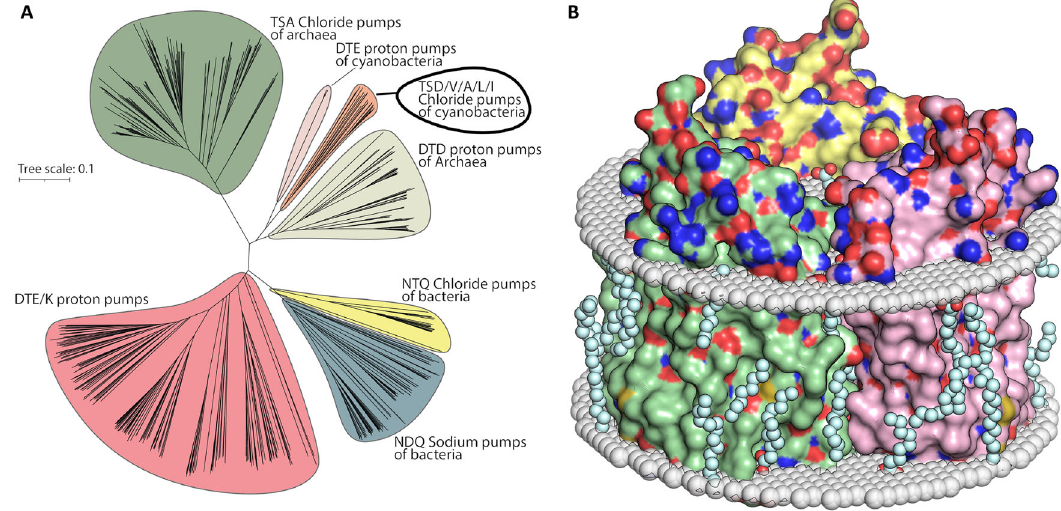
Fig. 1 | Phylogenetic tree of microbial rhodopsins and organization of Sy HR trimerinthemembrane.A Phylogenetictreeofprokaryoticmicrobialrhodopsins acting as light-driven iontransporters. Conducted ions and alternating three letter motifs (85, 89 and 96 amino acid positions according to Hs BR) are speci fi ed for each clade. Tree scale is indicated by a horizontal line (substitutions per site). B Organization of trimer of ground state of chloride bound Sy HR in membrane.